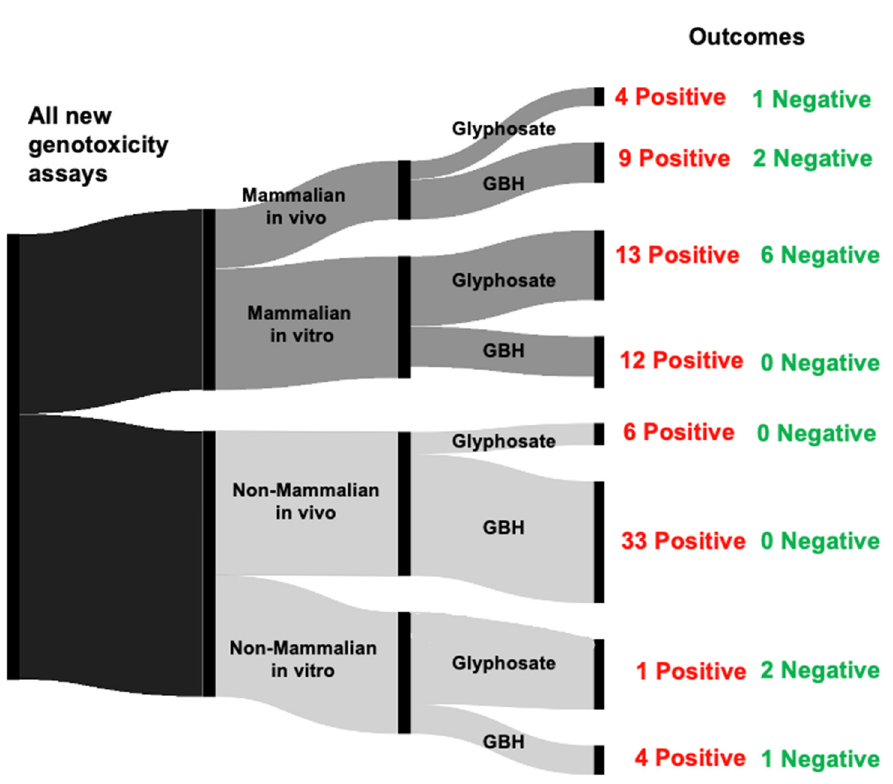
Figure 1. Sankey chart summarizing the results of genotoxicity assays published since the EPA and IARC reviews of glyphosate and GBH oncogenicity, made with SankeyMATIC (https://sankeymatic. com, accessed on 10 October